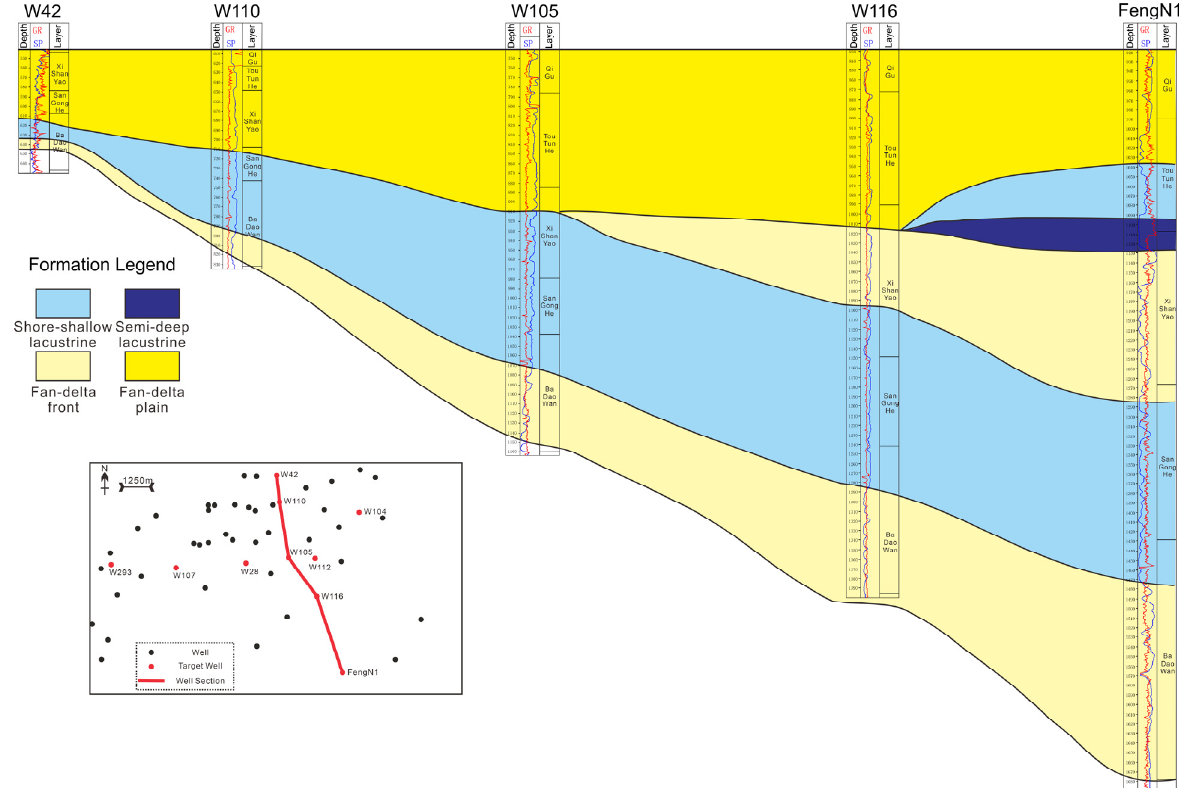
Figure 9. Sedimentary facies diagram of a north–south connecting well.